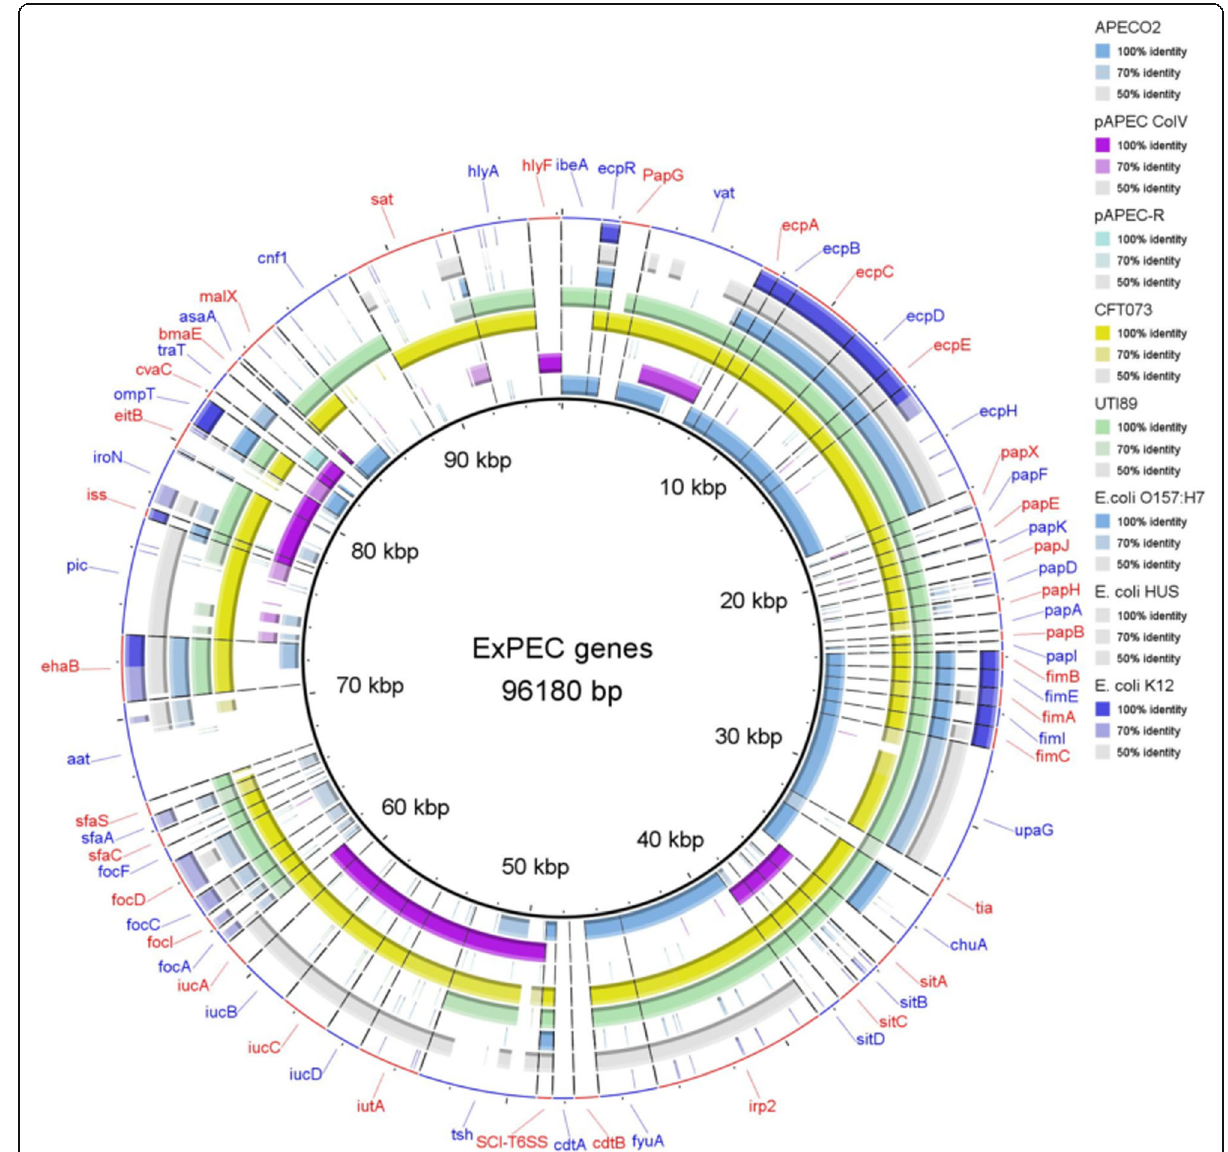
Fig. 4 Screening for the presence of selected virulence genes. The presence or absence of 65 genes related to extra-intestinal disease in APEC_O2. For comparison reasons the genomes of two plasmids of the wildtype of APEC_O2 (pAPEC ColV(NC_007675.1) and APEC-R (AY214164)), in addition to the genomes of CFT073(NC_004431.1, UTI89 (NC_007946.1), E. coli HUS (PRJNA68275), E. coli O127 (PRJNA204937), E. coli O157:H7 (GCA_000008865.1) and E. coli _K12 (GCA_000005845.2), respectively, were also included in the analysis. All genomic sequences of the virulence genes were obtained from the online Virulence Factor Database